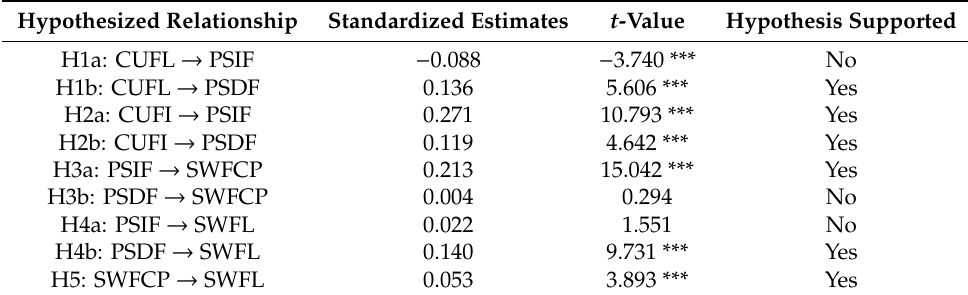
Table 6. Results of hypotheses